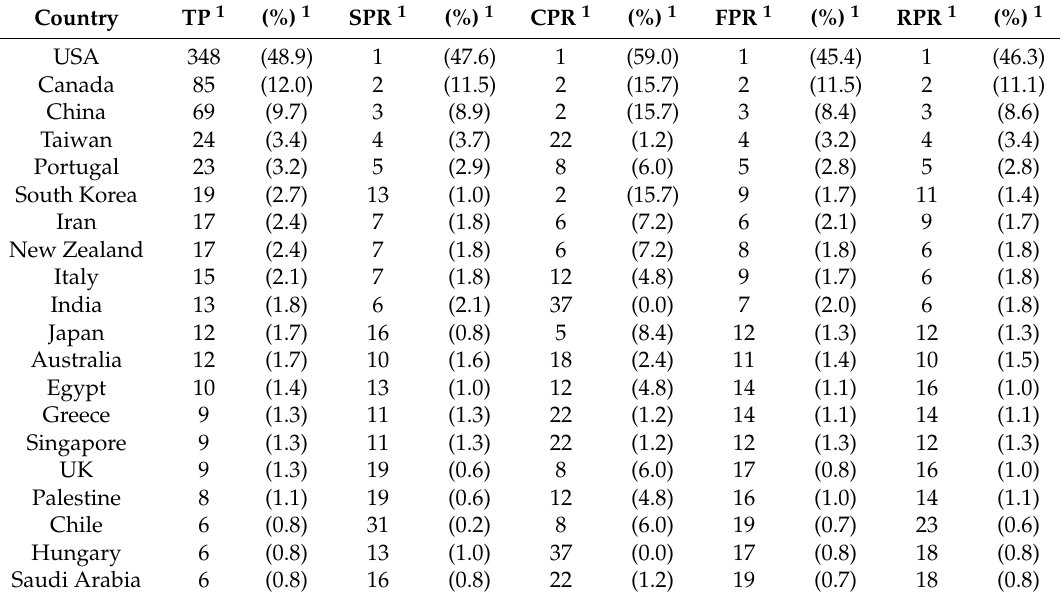
Table 2. The top 20 most productive